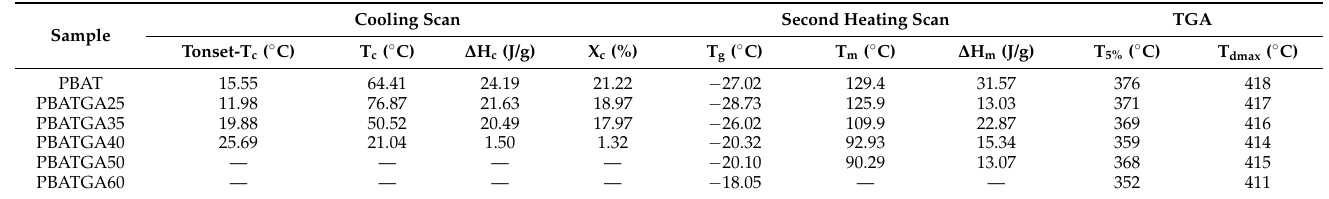
Table 2. Nonisothermal crystallization and thermal property parameters of PBATGAs.